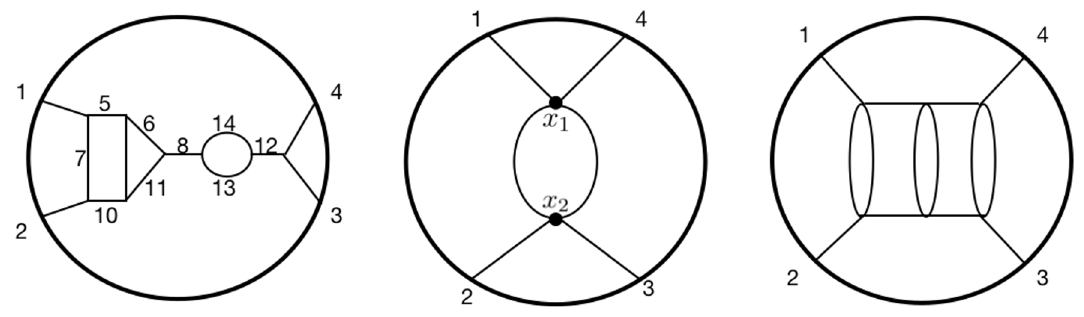
Figure 7 . Left: an example of a mixed ladder-bubble diagram in φ 3 theory on AdS. Middle: the 4-point 1-loop bubble diagram in φ 4 theory. Right: an example of a φ 4 ladder